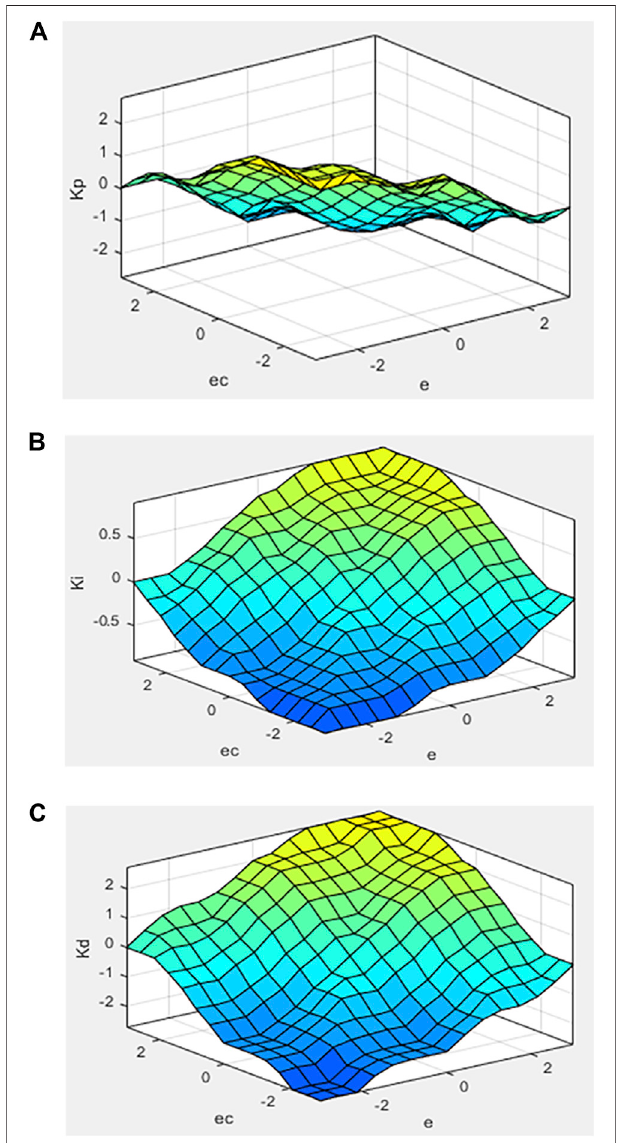
FIGURE 6 | Characteristic face of the fuzzy inference system ( A : Δ K p , B : Δ K i , C : Δ K d ).